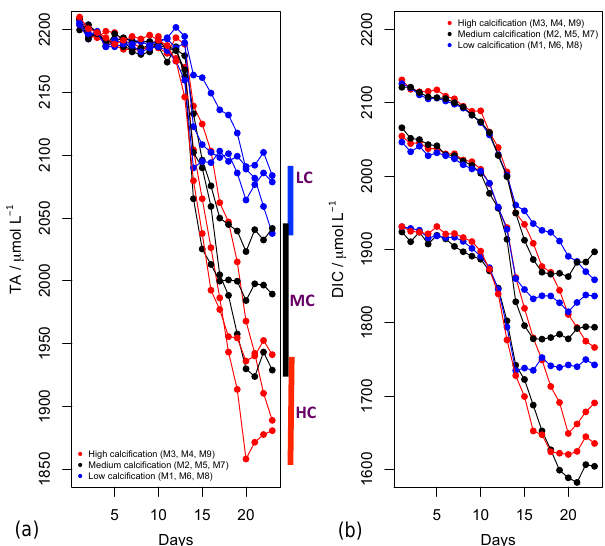
Figure 3. (a) shows three distinct calcification patterns, reflected in total alkalinity (TA) data. Those mesocosms that exhibit high TA values (a reduced drawdown during the bloom and post-bloom pe- riod) feature rates of low calcification (LC, in blue colour). Meso- cosms with low TA values (a strong reduction of TA) reveal rates of high calcification (HC, marked red). Rates of medium calcification (MC) are assigned to the remaining mesocosms (with intermediate TA values, marked black). (b) shows the respective different CO 2 treatments in the same colours as for LC, MC, and HC. The fig- ure shows that each calcification case (LC, MC, and HC) includes mesocosm of all three CO 2